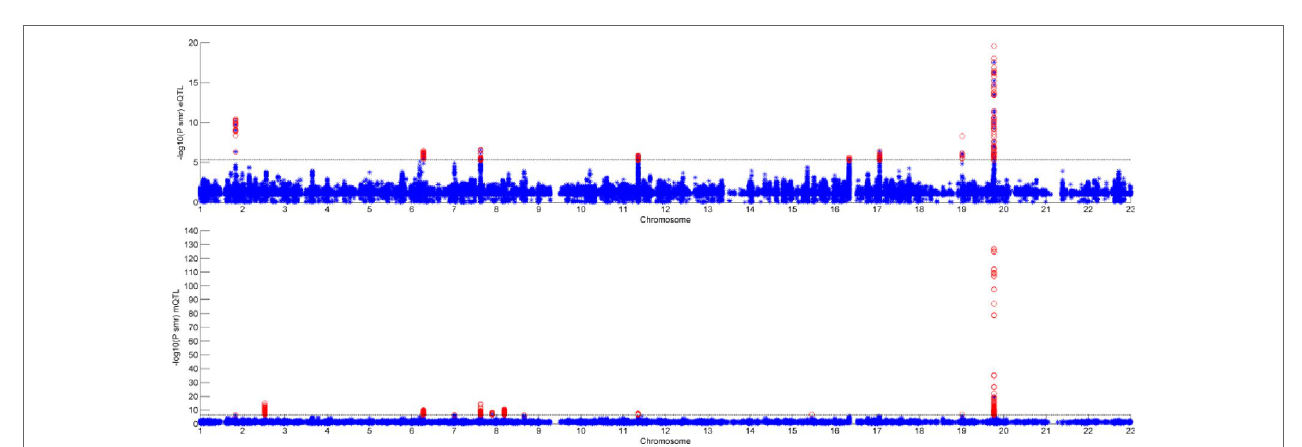
FIGURE 6 | Result of summary data-based Mendelian randomization (SMR).